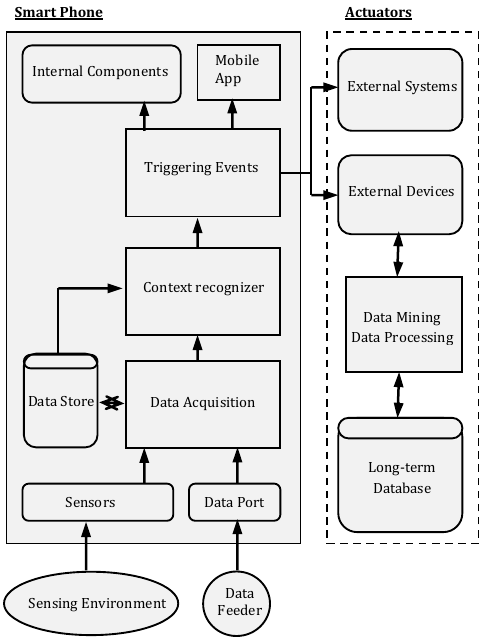
Figure 1: System Architecture of UbiSound